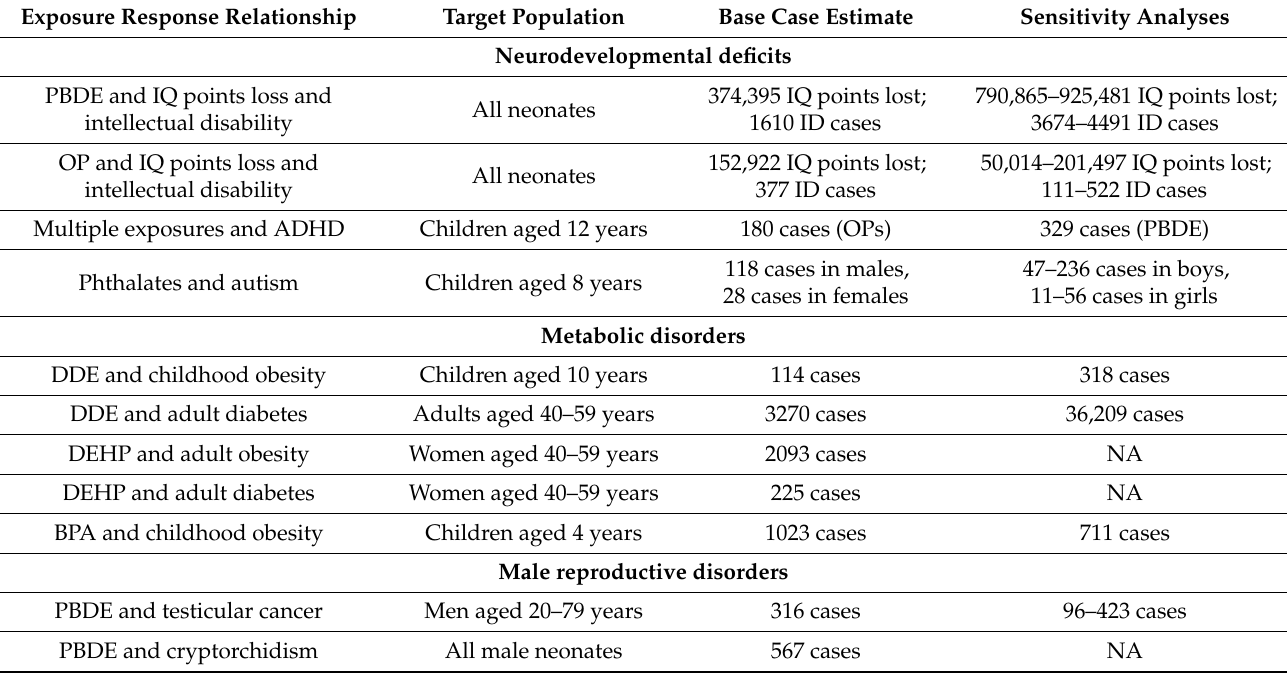
Table 1. Attributable burden of disease for 15 exposure–response relationships in